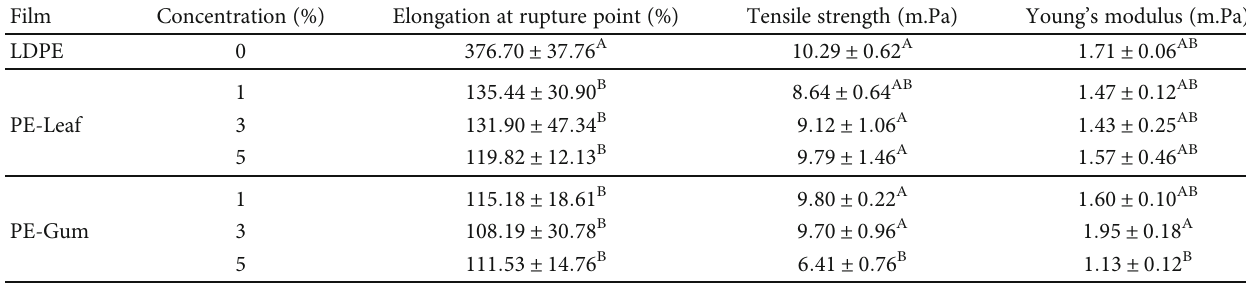
Table 2: Mechanical properties ( mean ± SD ) of control and active fi lms.